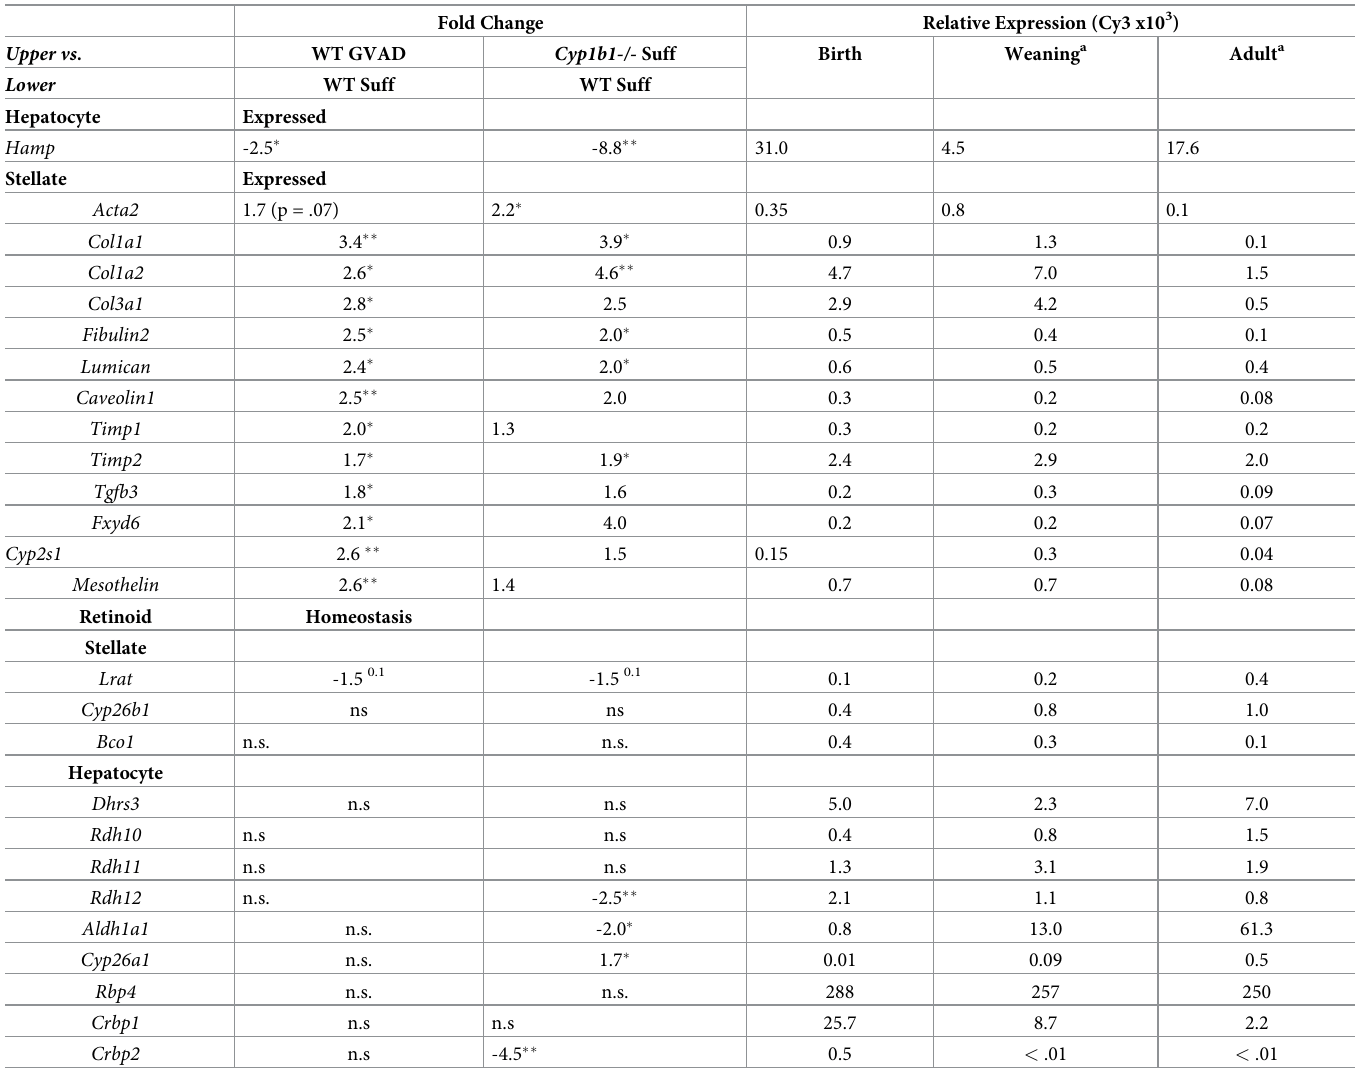
Table 2. Stellate cell markers are elevated in liver at birth by GVAD and Cyp1b1 deletion. Fold Change Relative Expression (Cy3 x10 3 ) Upper vs